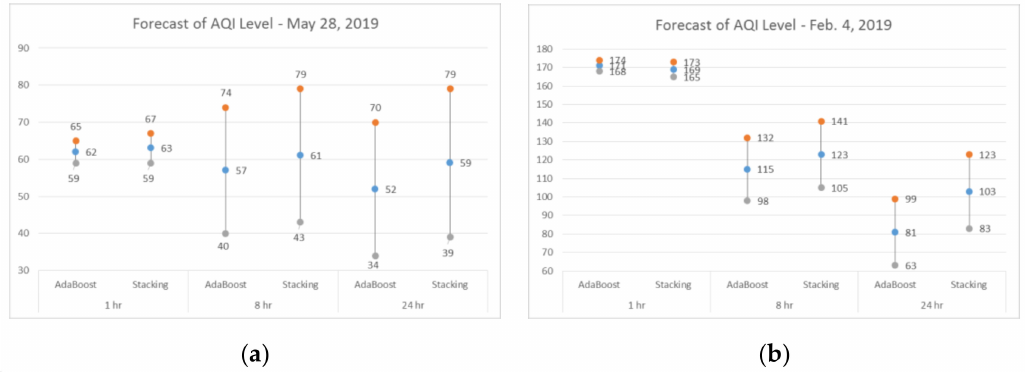
Figure 8. Forecast of AQI: ( a ) on 28 May 2019, 07:00; ( b ) on 4 February 2019,